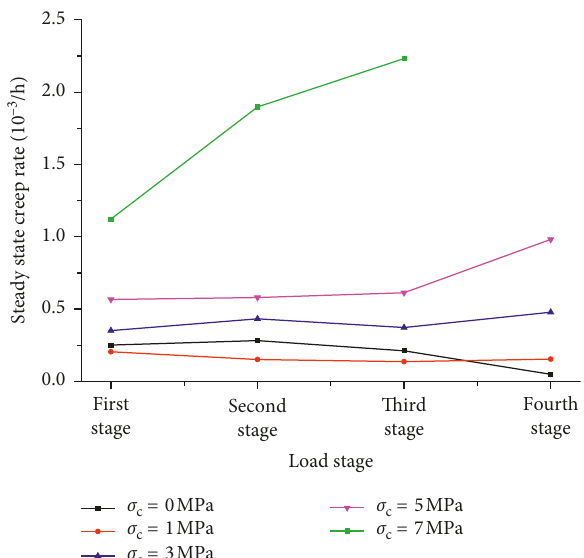
Figure 9: Creep strain rate of each creep stage at different confining pressures.